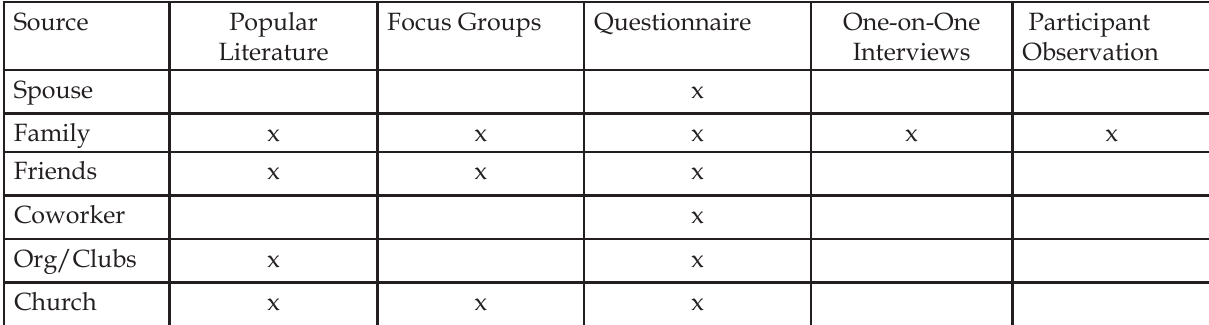
Table II. Sources of Instrumental